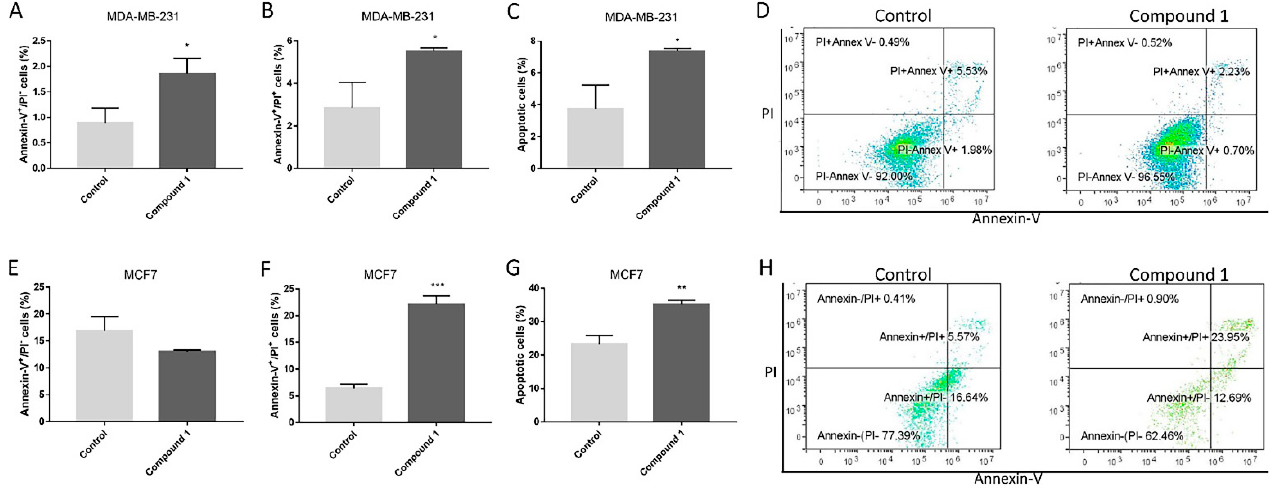
Figure 2. Apoptosis after compound 1 treatment. Notes: Percentage and dot plots of early, late and total apoptotic cells without and with 1 treatment for 48 h in the MDA-MB-231 ( A – D ) and in the MCF-7 cell line ( E – H ). Data represented are expressed as a mean from experiment performed in triplicate ± SD. Columns, mean of cells; bars, SD; * p < 0.05; ** p < 0.01 *** p < 0.001. SD, standard deviation.